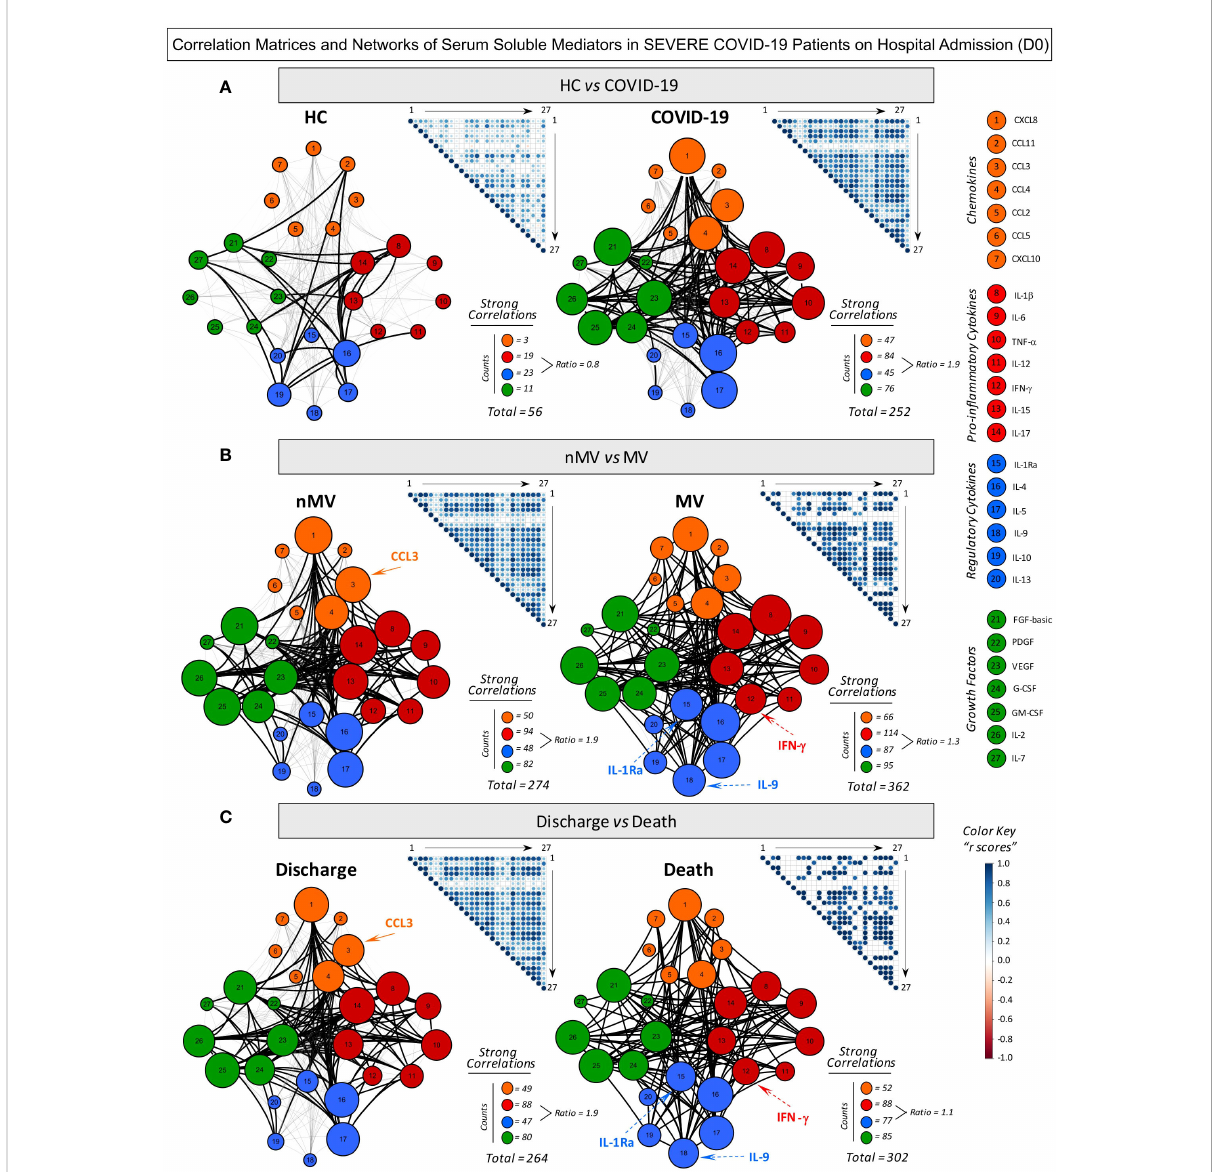
FIGURE 2 Correlation matrices and networks of serum soluble mediators in severe COVID-19 patients on hospital admission (D0). (A) Comprehensive correlation matrices and networks were assembled for serum chemokines, pro-in fl ammatory cytokines, regulatory cytokines, and growth factors observed in patients with severe COVID-19 (n=82) and non-infected pre-pandemic Healthy Controls (HC, n=164). COVID-19 patients were further categorized into subgroups according to disease outcome, referred to as: (B) Non-Mechanical Ventilation (nMV, n=71) vs Mechanical Ventilation (MV, n=11) and (C) Discharge (n=75) vs Death (n=7). The soluble mediators were measured by Luminex Bio-Plex platform as described in Material and Methods. Data analyses were performed by Pearson and Spearman rank tests and signi fi cant correlations at p<0.05 employed to build template matrices overview with each square intersection representing the “ r ” correlation scores between pairs of attributes. Color key scaled from − 1 to +1 was used to identify positive (blue) and negative (red) correlations and white squares indicating non-signi fi cant correlations. Networks were built considering all signi fi cant correlations, using a cluster layout for each category of serum soluble mediators, with nodes representing: chemokines (Orange nodes – 1=CXCL8; 2=CCL11; 3=CCL3; 4=CCL4; 5=CCL2, 6=CCL5 and 7=CXCL10), pro- in fl ammatory (Red nodes – 8= IL-1 b ; 9=IL-6; 10= TNF- a ; 11=IL-12; 12= IFN- g ; 13=IL-15 and 14=IL-17), regulatory cytokines (Blue nodes – 15=IL-1Ra; 16=IL-4; 17=IL-5; 18=IL-9; 19=IL-10 and 20=IL-13) and growth factors (Green nodes – 21=FGF-basic; 22=PDGF; 23=VEGF; 24=G- CSF; 25=GM-CSF; 26=IL-2 and 27=IL-7). Connecting edges illustrates weak/moderate ( “ r ” scores between |0.1 to 0.67|, thin gray lines) and strong correlations ( “ r ” scores ≥ |0.67|, thick black lines). Negative correlations are represented by dashed lines. Node sizes are proportional to the number of strong neighborhood connectivity between pairs of attributes. The number of strong correlations (Total and Intra-cluster) as well as the pro-in fl ammatory/regulatory ratio of strong correlations were used for comparative analysis of COVID-19 vs HC and between COVID-19 subgroups (nMV vs MV and Discharge vs Death). Nodes with distinct neighborhood connectivity associates with good (nMV and Discharge) or poor prognosis (MV and Death) are highlighted by continuous or dashed arrows,